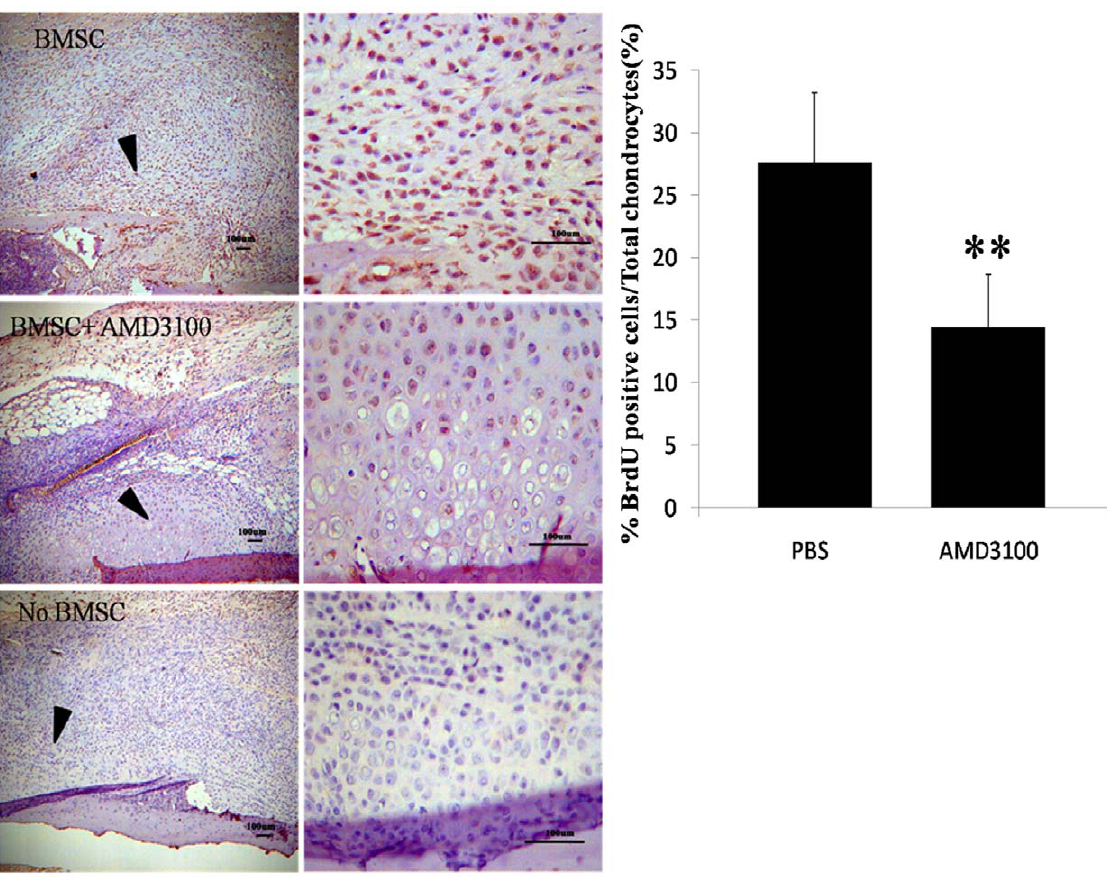
Figure 7. In vivo chemotaxis assay in TBI/fracture model. Sections obtained on day 7 after surgery for histologic and immunohistochemical analysis. In the specimens treated with PBS, positive BrdU staining was detected in the developing callus. The number of migrated cells was significantly reduced when treated with AMD3100 (**P , 0.001).